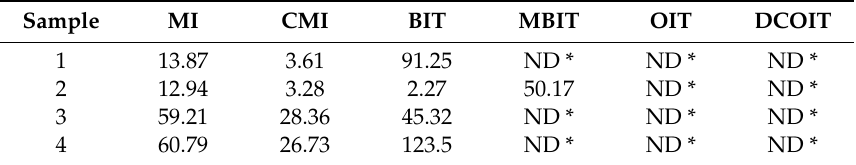
Table 3. The concentration of six isothiazolinones (mg / kg) in water-based adhesive under optimized experiment condition. Sample MI CMI